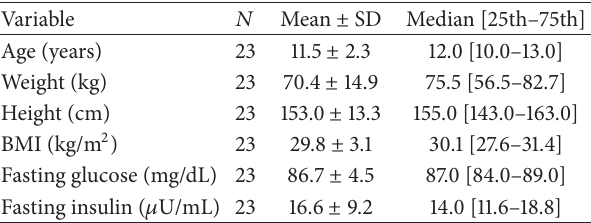
Table 1: Characteristics of enrolled subjects at baseline.